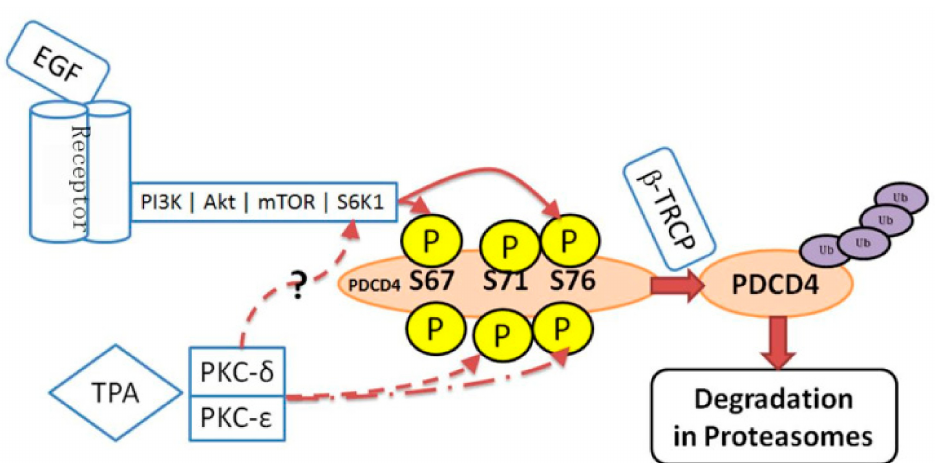
Figure 7. EGF and TPA mediated pathway to phosphorylate serines in the SCF β TRCP recognition site of PDCD4-protein in Huh7 hepatoma cells. EGF activates PI3K-Akt-mTOR-S6K1 signaling pathway and the activated S6K1 phosphorylates PDCD4-protein at S67 and S76. TPA-mediated pathway via PKC- δ and / or PKC- ε may phosphorylate S71 and S76. PKC-dependent activation of S6K1 was not observed in Huh7 hepatoma